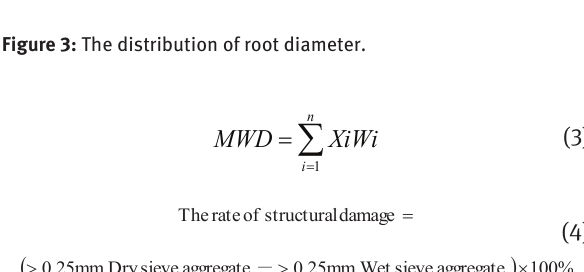
Table 2: Basic properties of the tested soil.